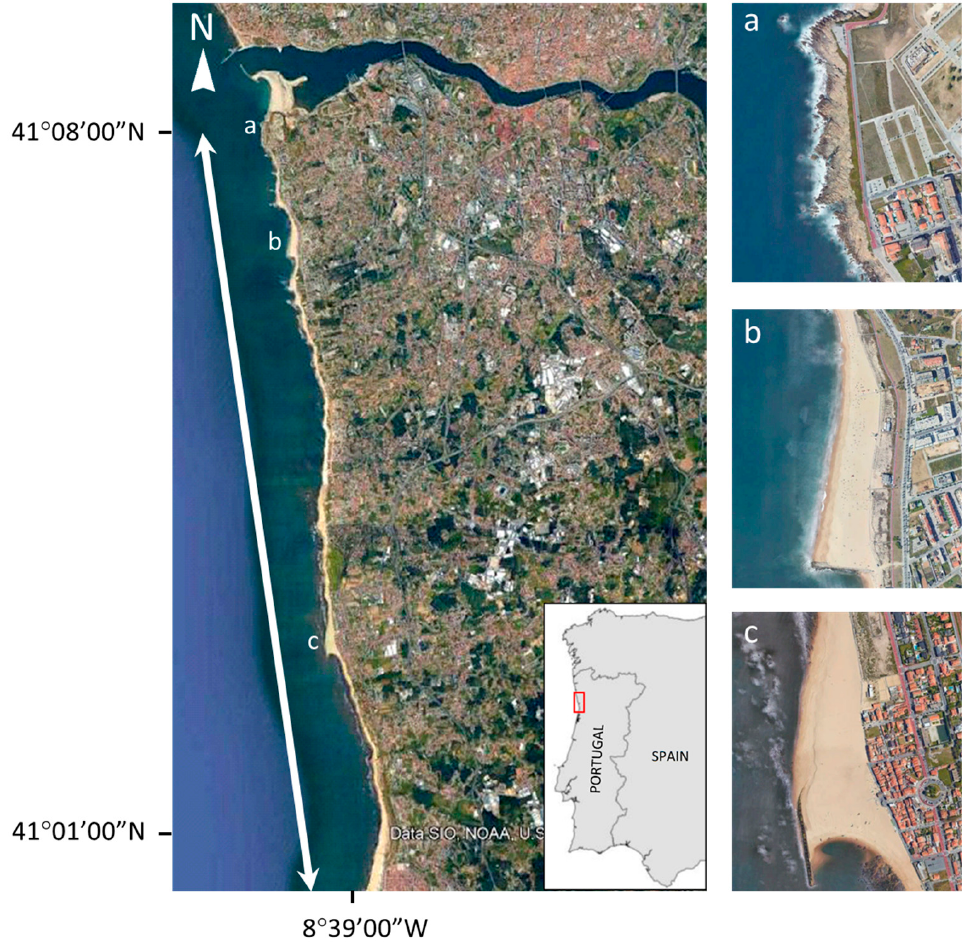
Figure 1. The Vila Nova de Gaia coast (left panel) and its location in Northern Portugal (red rectangle), and closeups of the rocky sector in the North ( a ), the groyne at Praia de Canide ( b ) and the breakwater at Aguda beach ( c ) (image: GoogleEarth, Data SIO, NOAA, U.S. Navy, NGA, GEBCO).